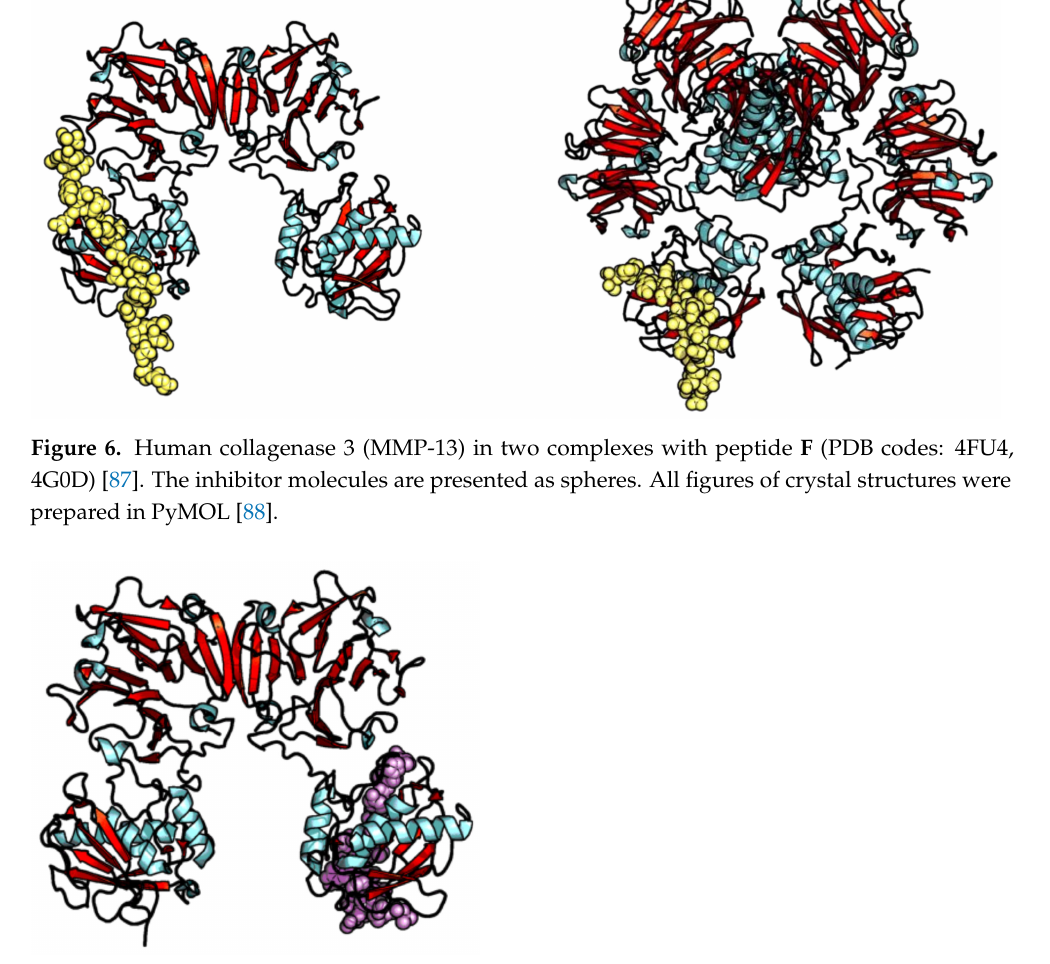
Figure 7. Human collagenase 3 (MMP-13) in the complex with peptide G (PDB code: 4FVL)